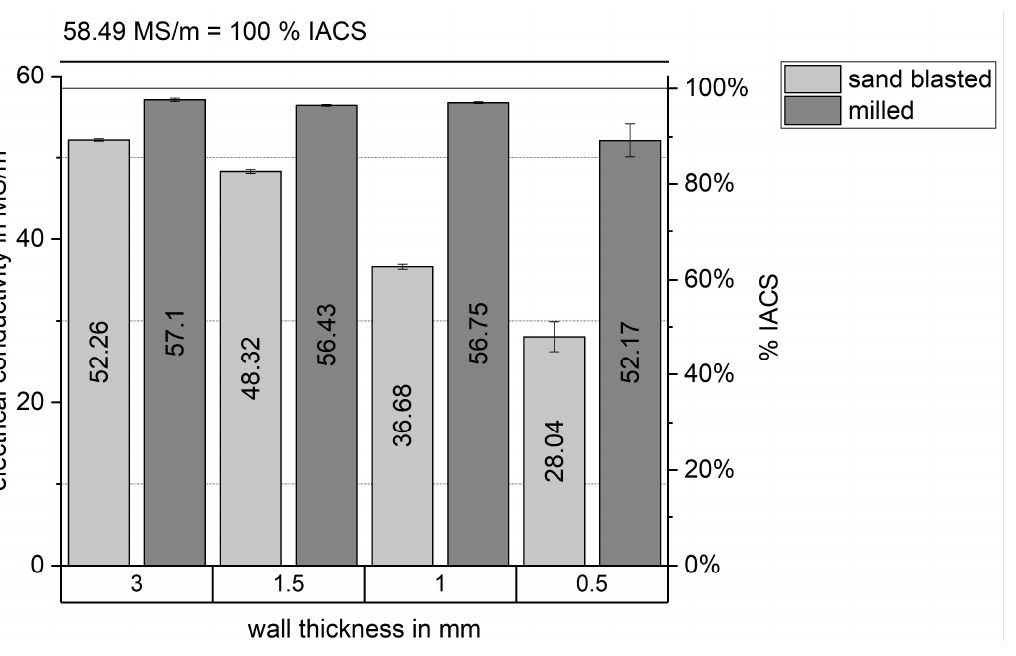
Figure 8. Effect of surface condition and wall thickness on measured electrical conductivity of Cu-OFHC.